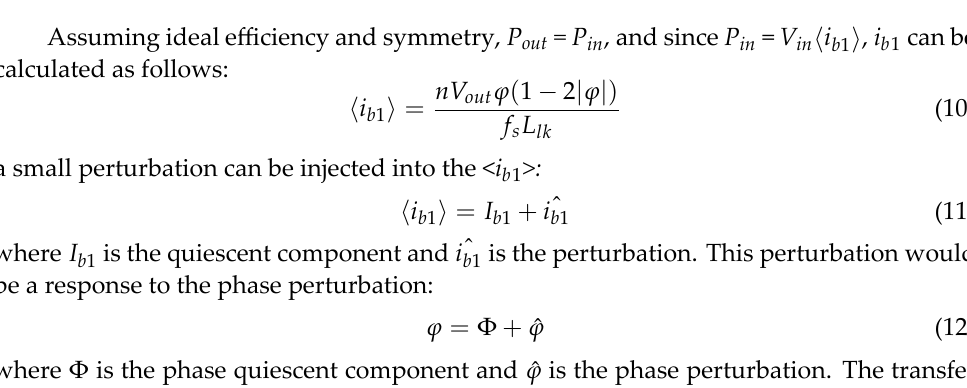
Figure 6. Equivalent circuit of the dual active bridge converter.